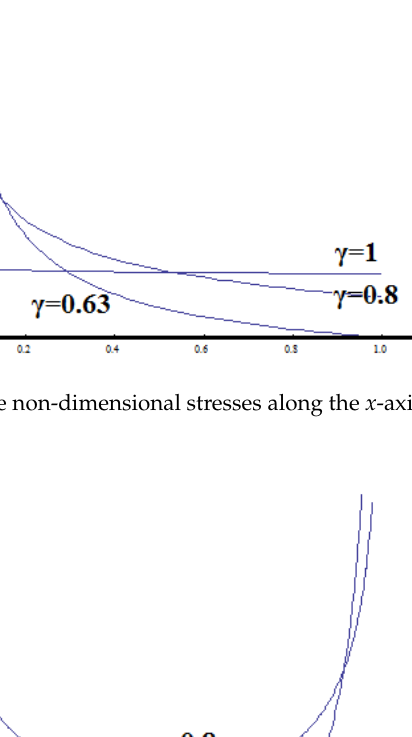
Figure 7. Non-dimensional stress distribution of the bar with left and right. Non-Local Action